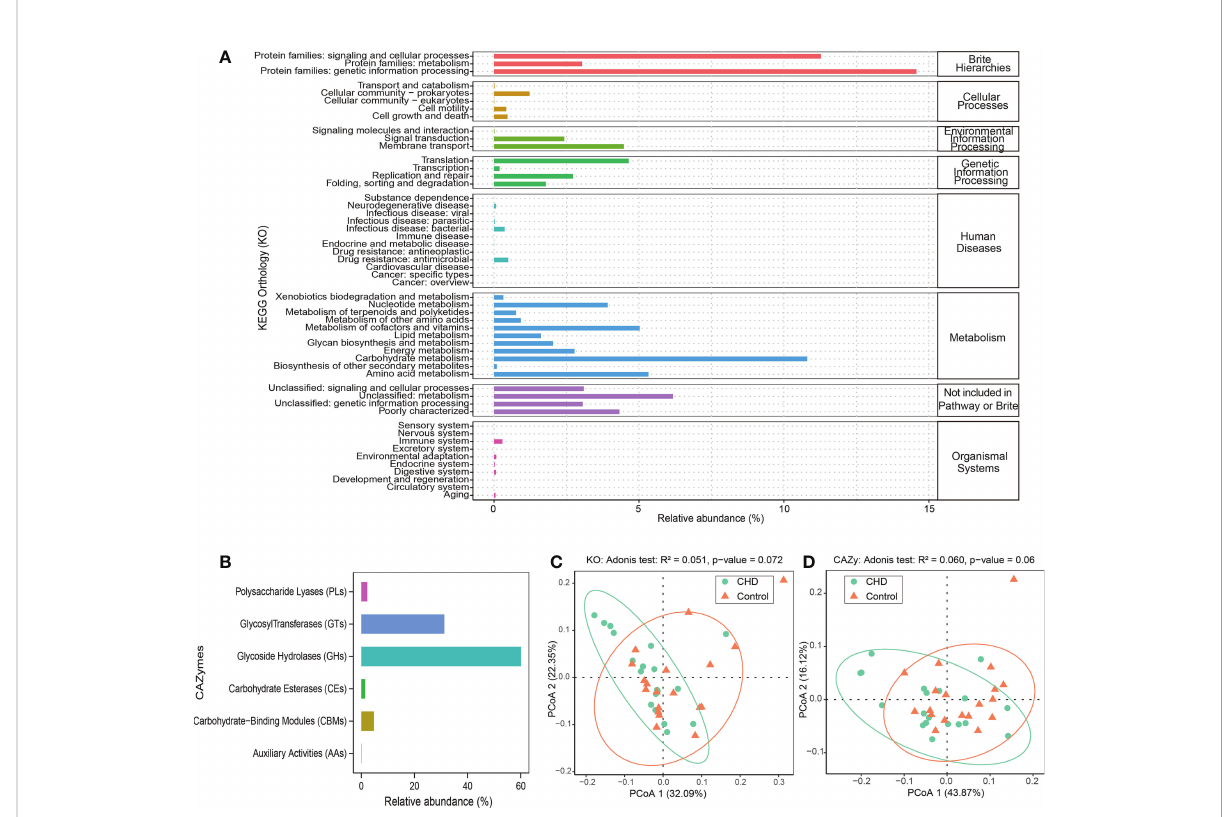
FIGURE 2 Function pro fi les of gut microbiota. (A) KEGG orthology (KO) relative abundance of gut microbiota. (B) carbohydrate-active enzymes (CAZymes) relative abundance of gut microbiota. (C, D) Dimensionality reduction PCoA and Adonis test of KO and CAZymes based on Bray-Curtis distance metrics between CHD and control